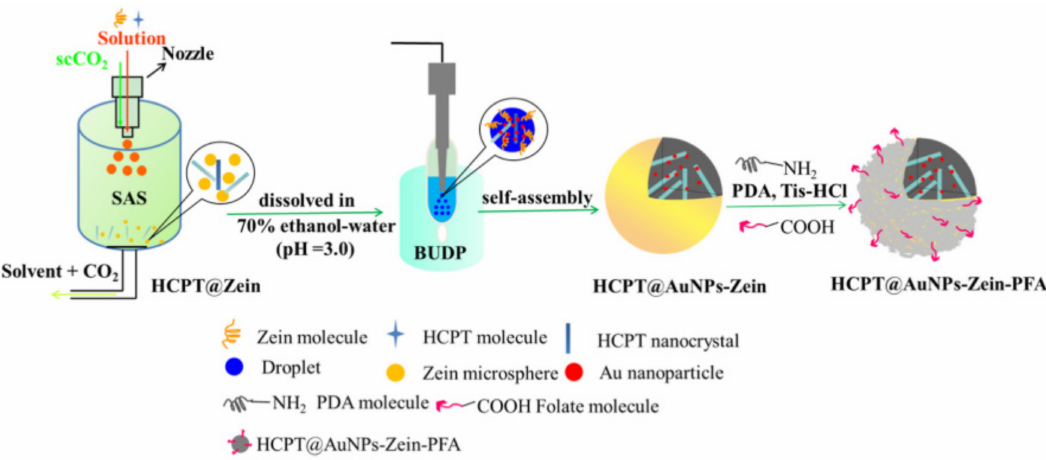
Figure 9. Schematic diagram of the preparation of HCPT@AuNPs-Zein-PFA NCs. Reproduced with permission from [94], ELSEVIER, 2021.